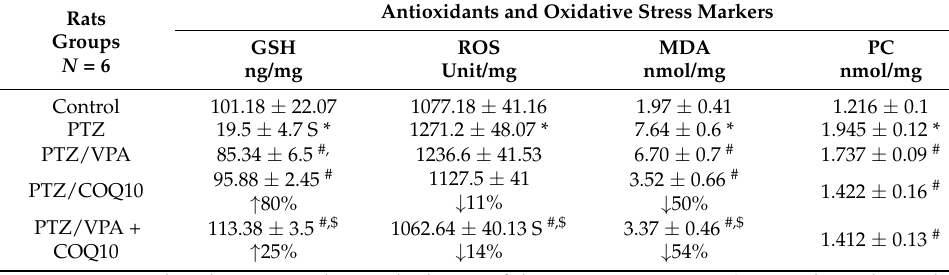
Table 2. Effect of CoQ10on antioxidants and oxidative stress markers in the hippocampus of rats subjected to PTZ